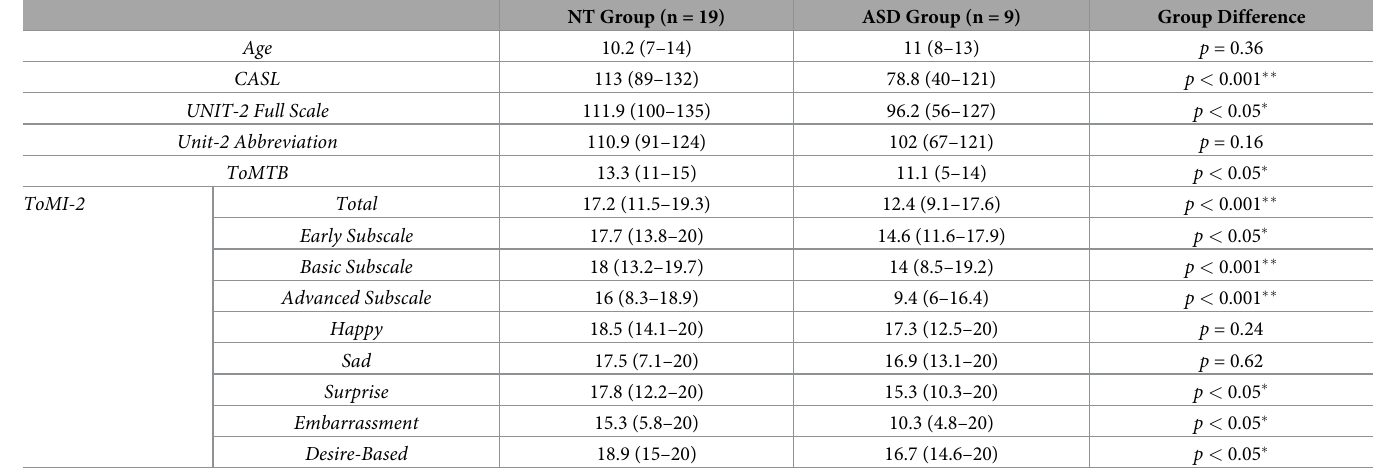
Table 1. Participant behavioral assessments scores: NT vs.